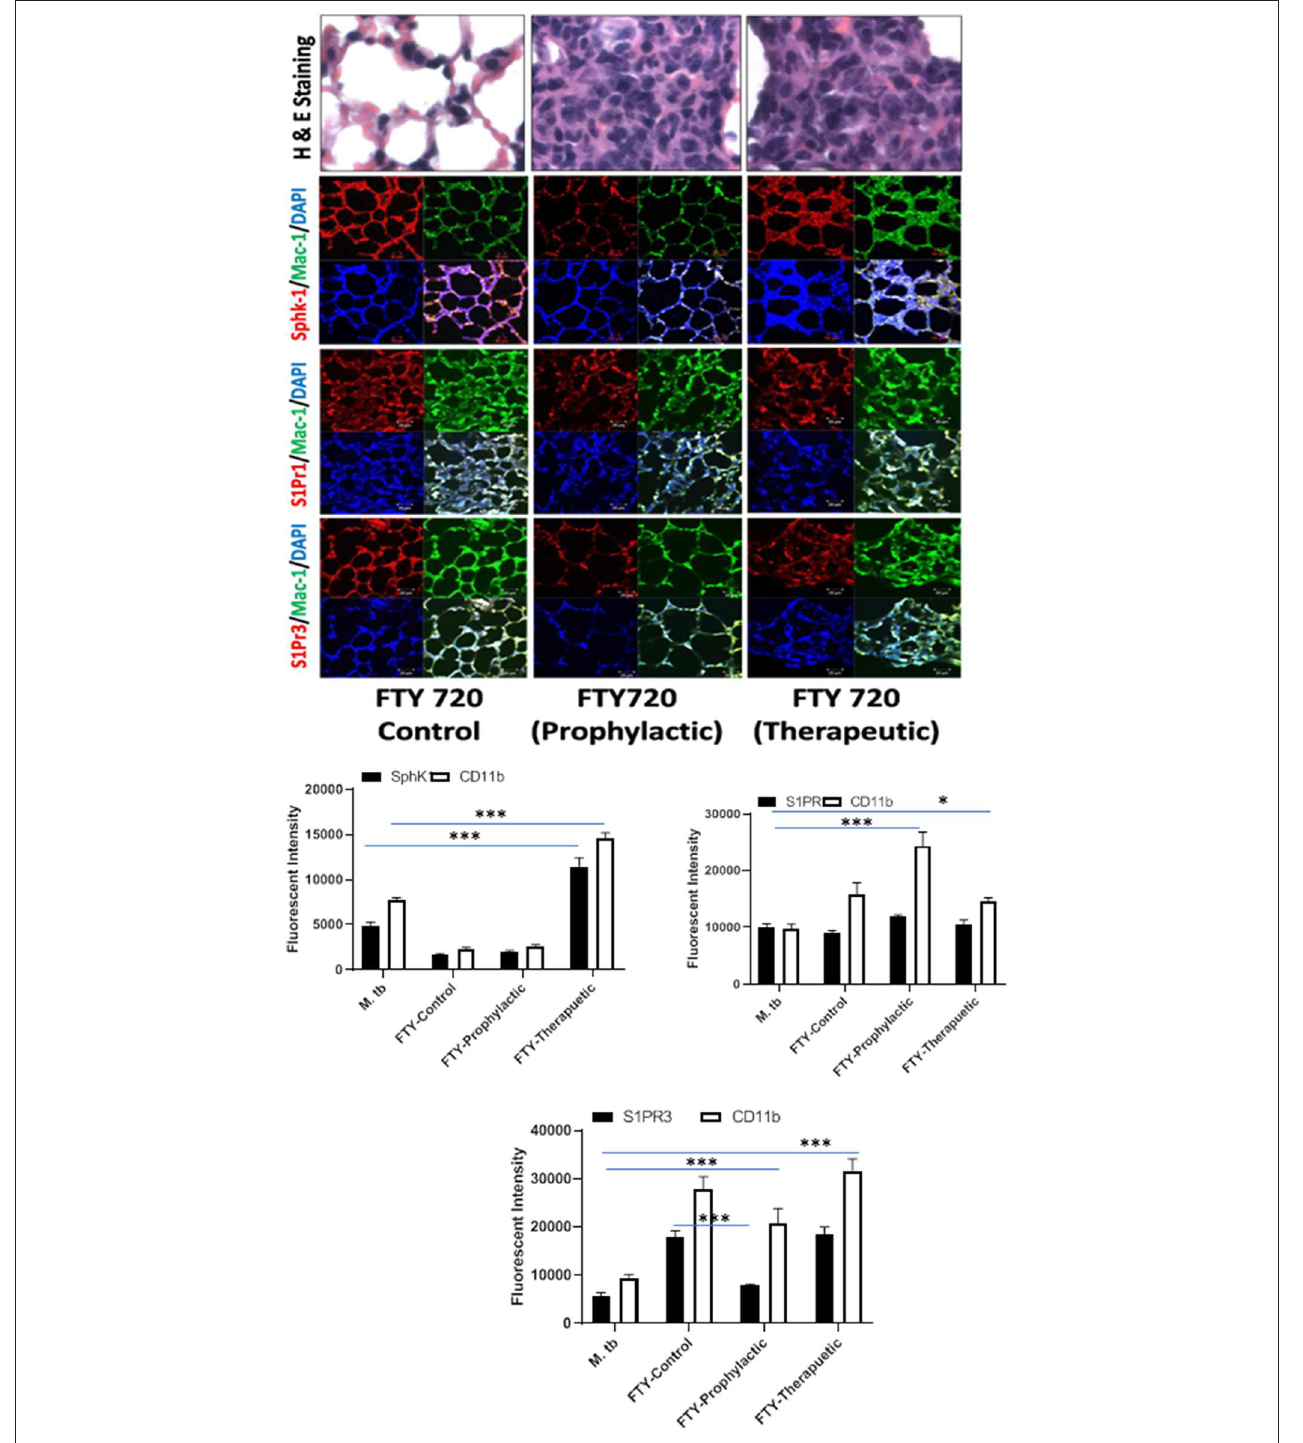
FIGURE 7 | FTY-720 enhances sphingosine-1-phosphate receptor (S-1PR)3 in M. tuberculosis –challenged animals. The infected mice were treated with FTY-720 as per Figure 3A , and cryosections of lungs from these mice were analyzed for expression of S-1PR1, S-1PR3, and SphK-1 and infiltration of CD11b + macrophages by confocal microscopy. Shown here is the representative images of mouse lung from each group. Mean fluorescence intensities of Sphk-1, S-1PR 1, and S-1PR3 expression were plotted against Mac1 expression. Statistical analyses were conducted using two-way ANOVA followed by Bonferroni posttest (* P < 0.05, *** P <